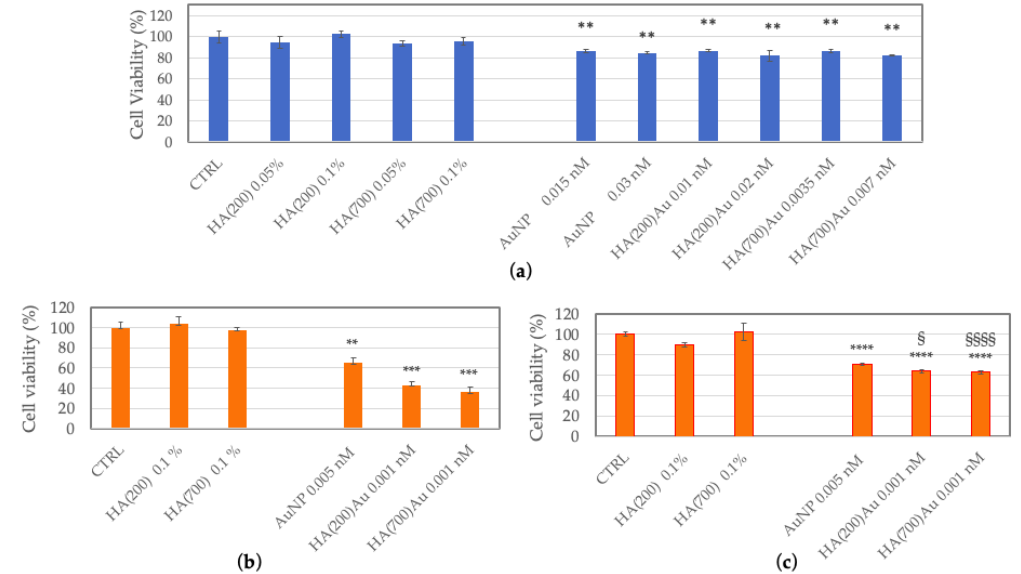
Figure 7. Viability of HUVEC ( a ), SH-SY5Y ( b ) or PC-3 ( c ) cells, untreated (CTRL) and after 24 h of